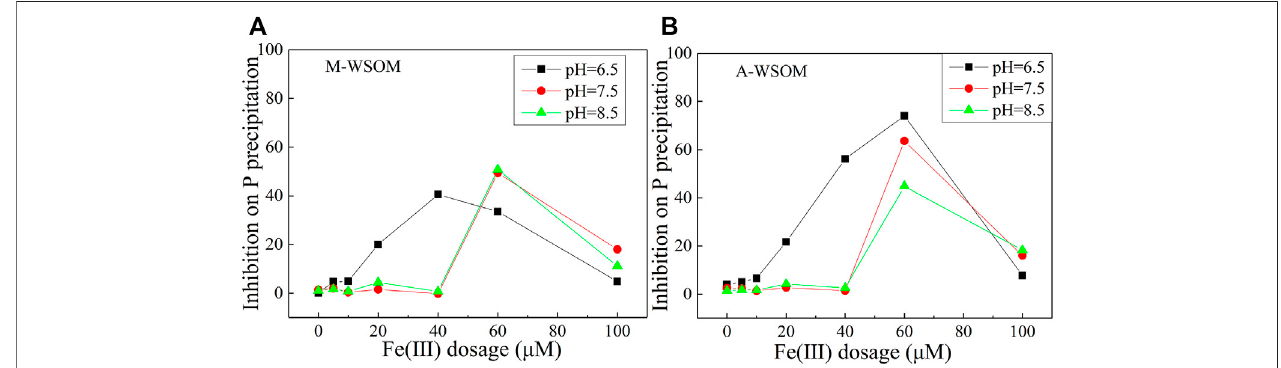
FIGURE 3 | Effects of Fe(III) dosage and pH values on M-WSOM ’ s (A) and A-WSOM ’ s (B) inhibition of P precipitation.